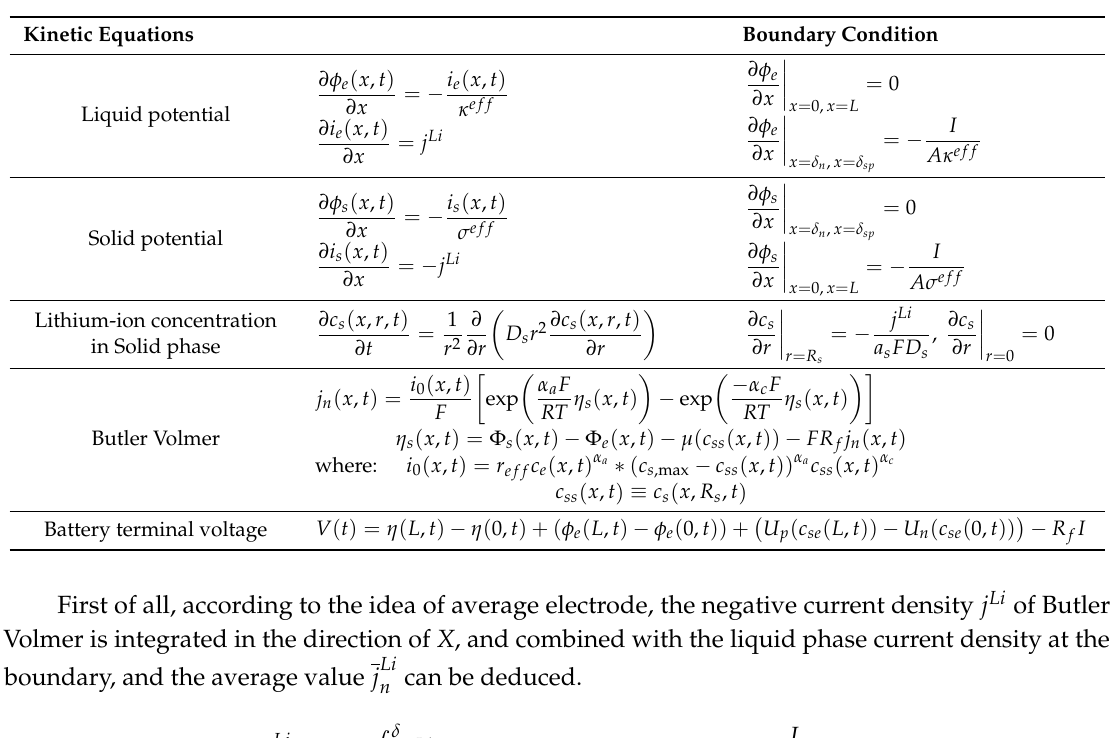
Table 1. Equations of electrochemical model for Li-ion